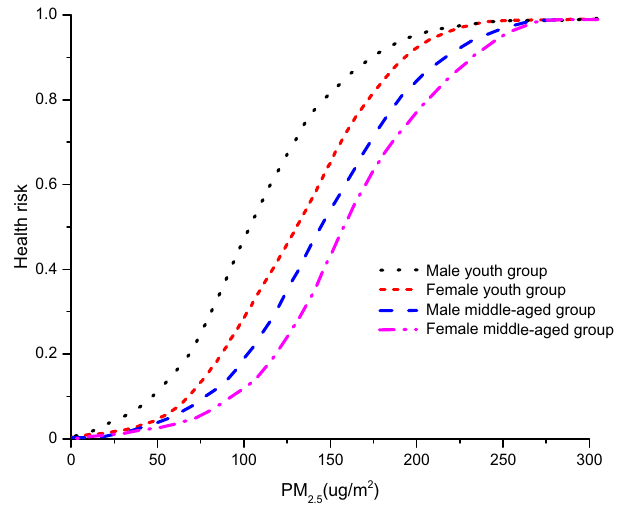
Figure 5. The probability of health risks in each group of volunteers as PM 2.5 concentration